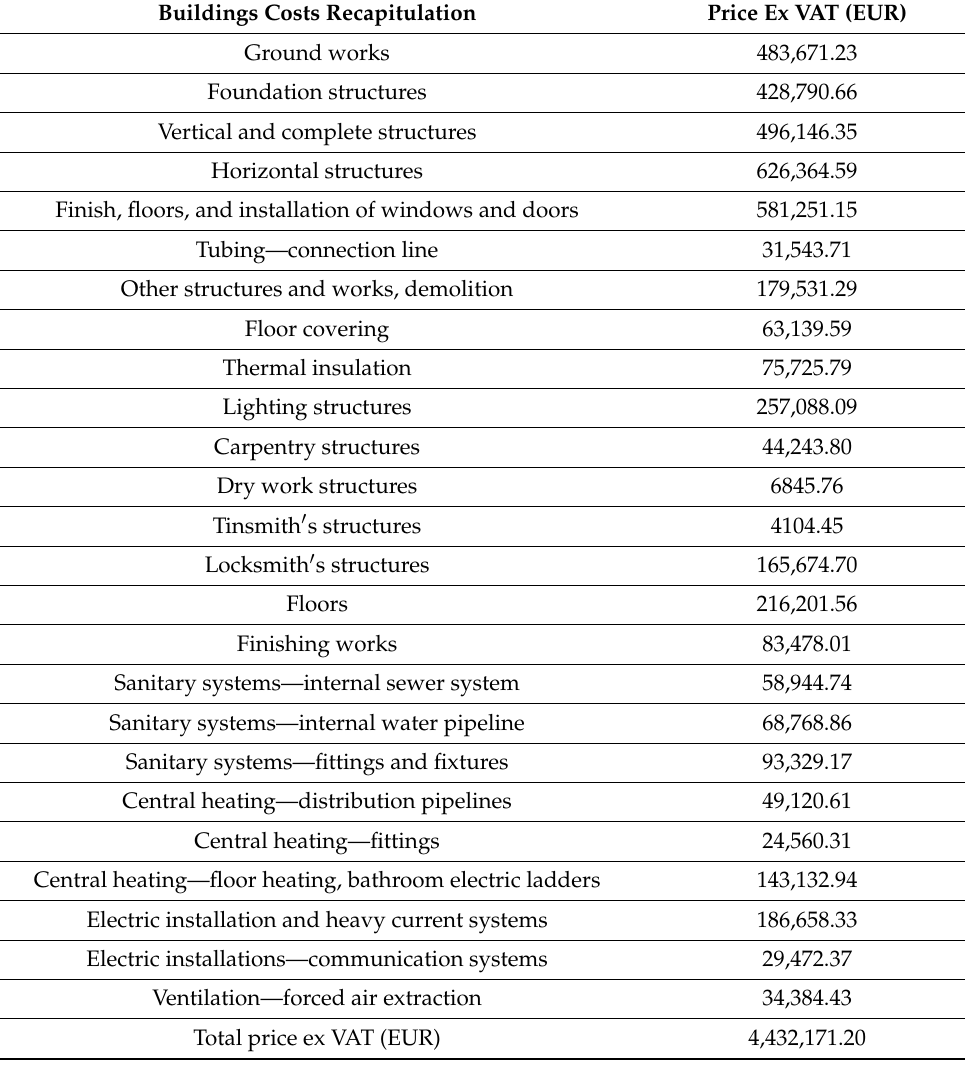
Table 6. Building costs of the concerned project.